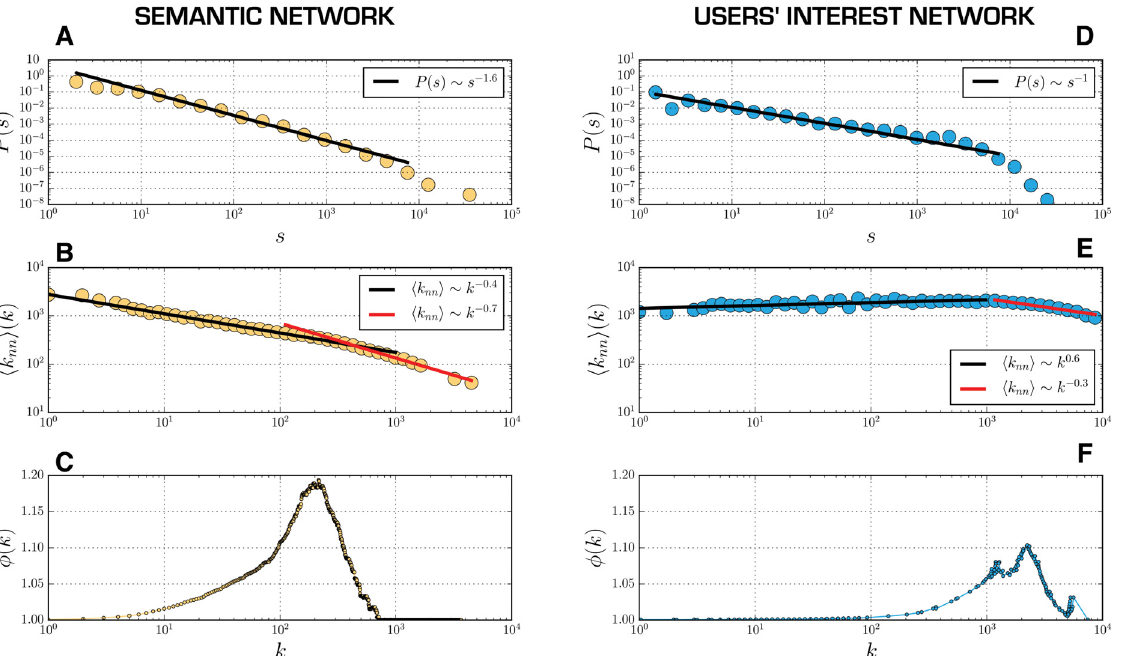
Fig 2. Stength, degree correlation and rich club index distribution for the two network projections. Plot A and D: Strength distribution of the semantic (A) and users ’ interest network (D). The distributions follow a power law with exponents respectively γ = -1.6 and γ = -1 respectively. In the case of the users ’ interest graph a pronounced exponential tail is observed. Plot B and E: Degree correlation of the semantic (B) and users ’ interest network (E). For the semantic graph the average neighbours' degree decreases sub-linearly with the degree. The decrease is faster for hubs. For the users ’ graph the average neighbors ’ degree increases very slowly with the degree for k < 10 3 . For the hubs ( k > 10 3 ) we observe a sub-linear decrease. Plot C and F: Normalized rich club index as function of degree for the semantic (C) and the users ’ interest network (F) For both networks the index is increasing with the degree indicating the existence of correlations in the tow networks. The decrease for large value is an effect of the networks finite sizes.